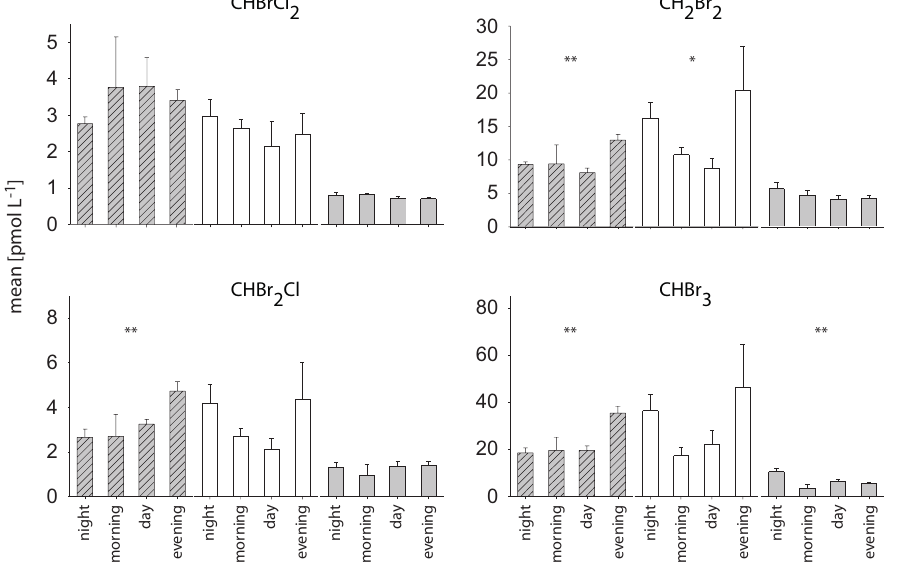
Fig. 7. Bromocarbon concentrations against time of the day in the upper water layers (surface to chlorophyll maximum). Data are clustered into three water masses: recently upwelled waters (gray shaded), aged upwelled waters (white) and open ocean waters (gray). Mean values at four different times (night, day, and the intermediate morning and evening). Night and day were defined as two hours before sunrise and sunset, respectively. Confidence levels: * significant at 90%. ** significant at